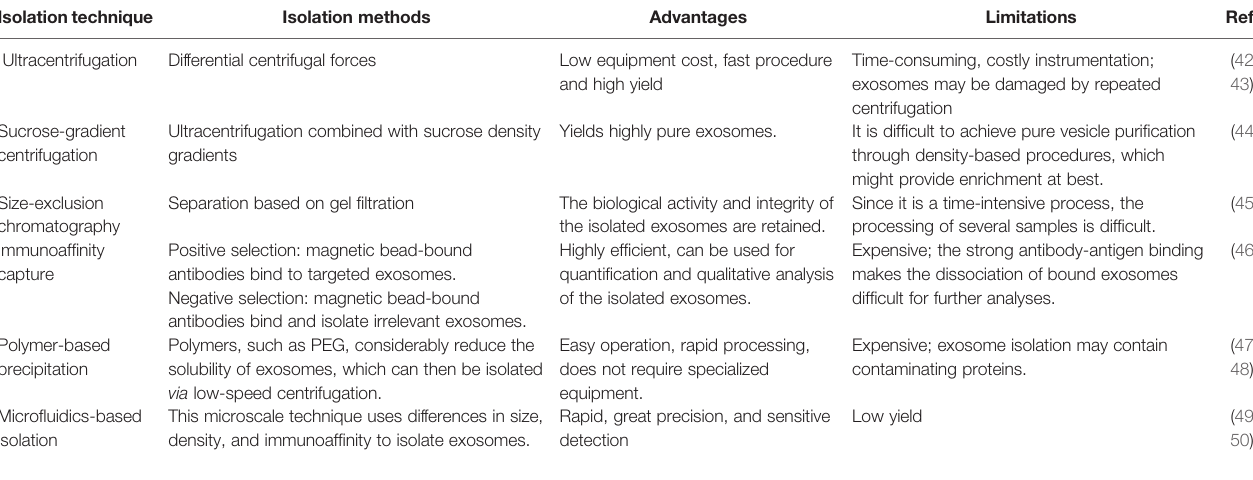
TABLE 1 | Isolation technique of